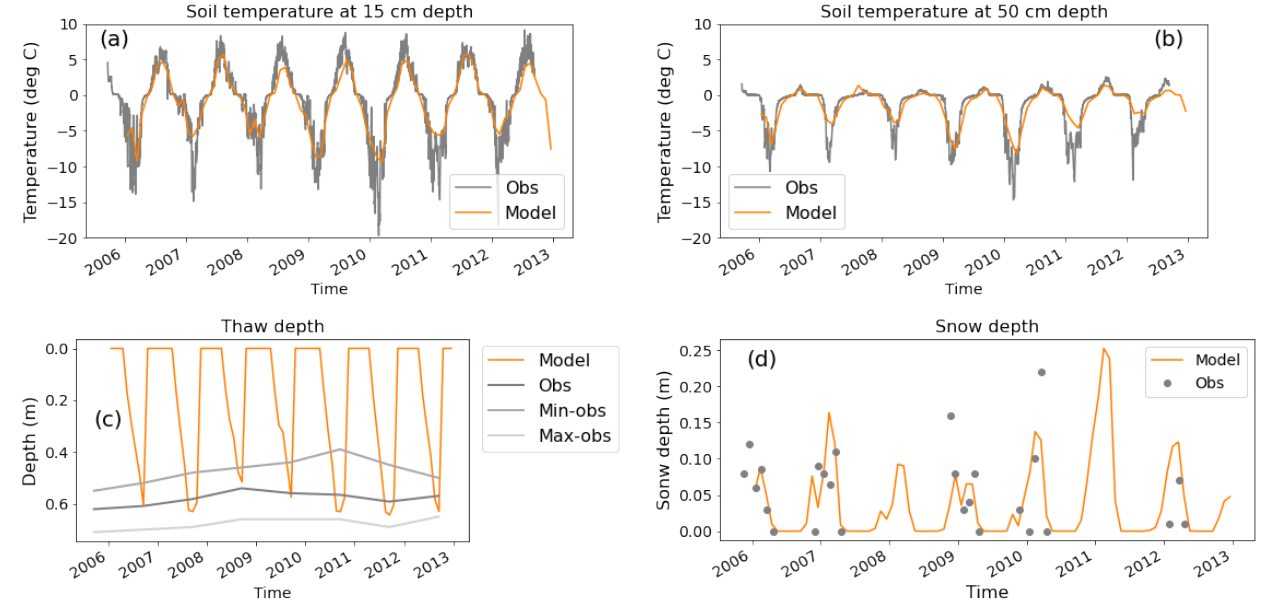
Figure 1. Soil temperature in °C at ( a ) 15 cm depth and ( b ) 50 cm depth. ( c ) The monthly mean simulated thaw depth (m) alongside the observed annual mean maximum summer thaw depth and its uncertainties. ( d ) The time series of the snow depth with the available